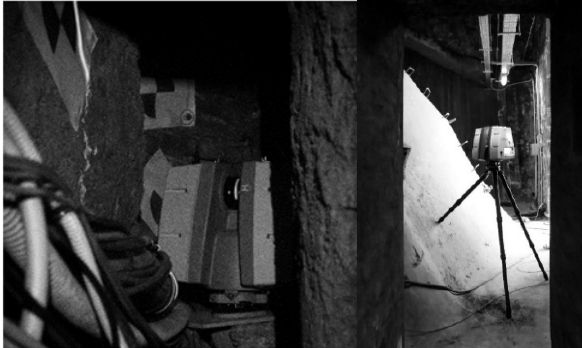
Figure 1. Laser scanner Leica C10 hardly levelled in a tunnel (left) and in the “sordine” environment (right).